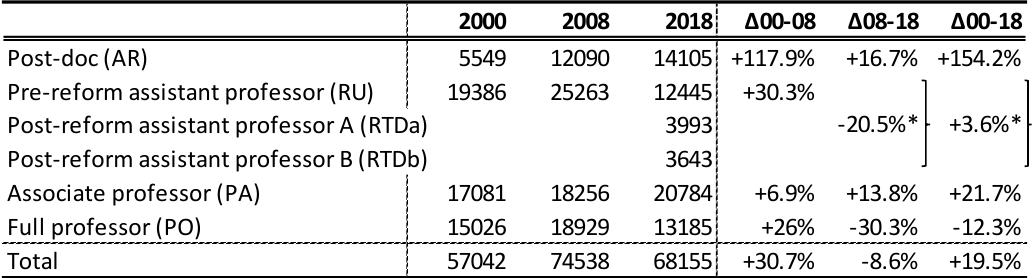
Table 2. Academics in Italy by rank and